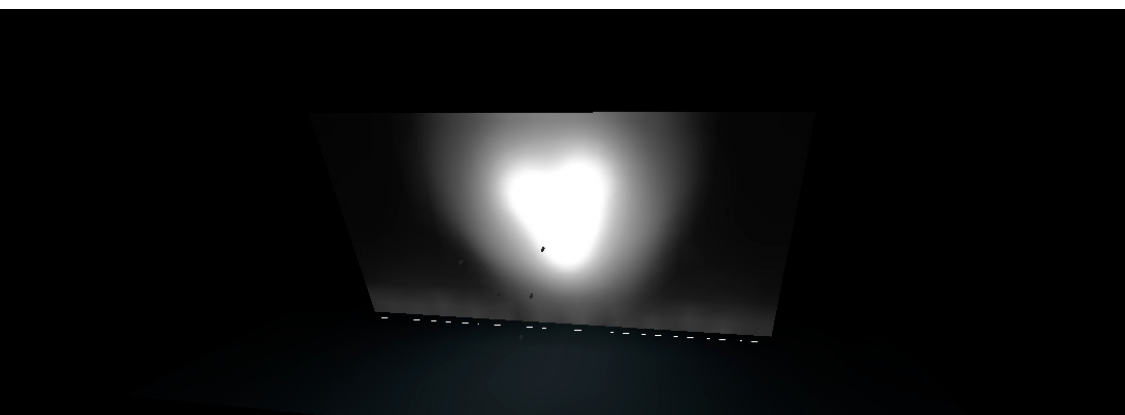
Figure 8. Simulation of visual result of Working Diagram I—Scene 1.